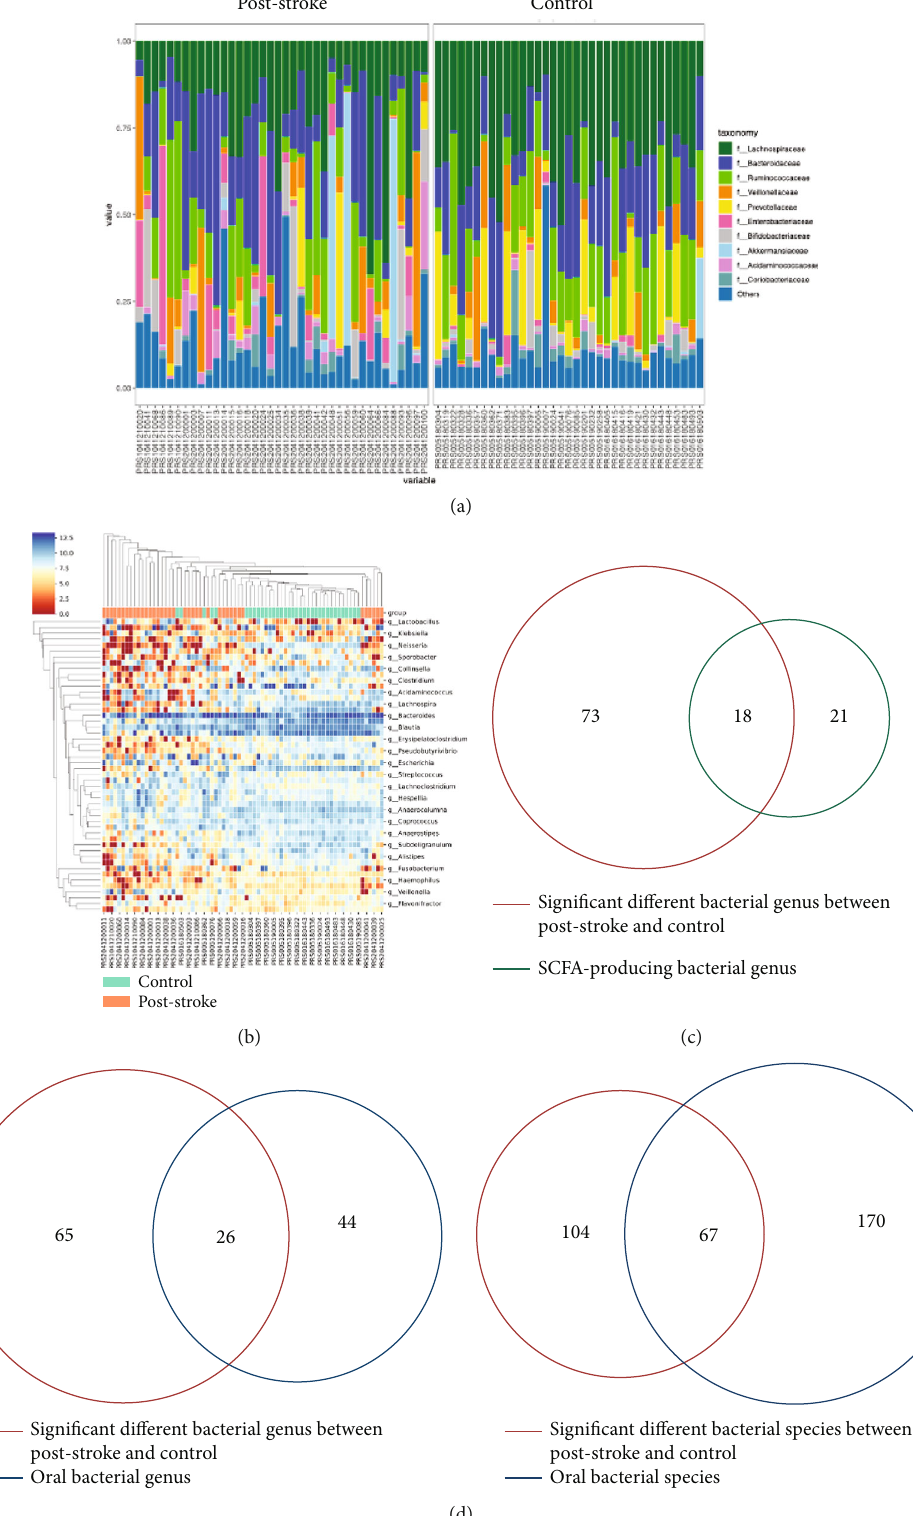
Figure 2: Alteration of gut microbiota composition. (a) Composition of gut microbiota at a family level. (b) Heatmap of gut microbiota composition at the genus level. (c) Venn diagram of the signi fi cantly di ff erent bacterial genus in poststroke and SCFA-producing bacterial genus. (d) Venn diagram of signi fi cantly di ff erent bacterial genus/species in poststroke and oral bacterial genus/species. SCFAs: short-chain fatty